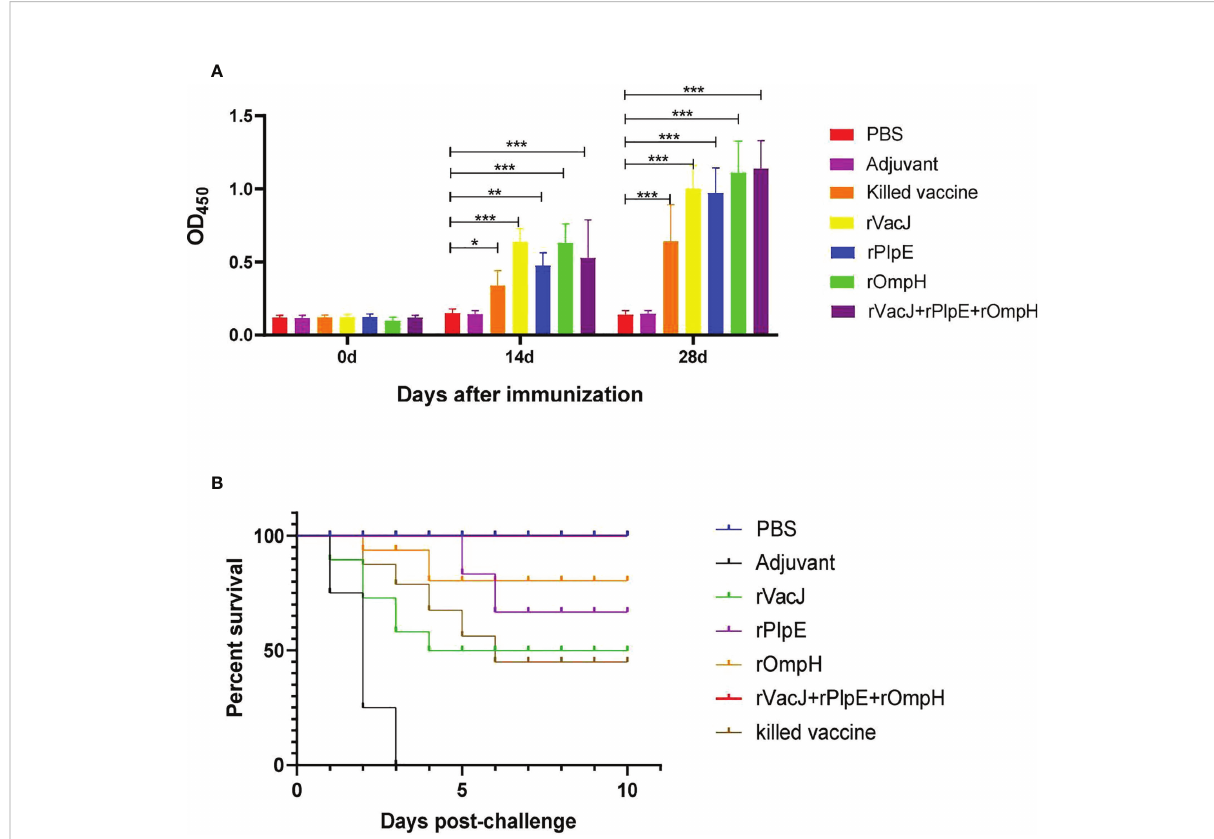
FIGURE 2 In a duck model, the ELISA and protective ef fi cacy of rVacJ, rPlpE, and rOmpH proteins. Panel (A) The bar diagram indicating the rVacJ, PlpE, and OmpH antibody titers (total IgG) of sera collected from all the ducks at 0, 14, and 28 days post-immunization. Panel (B) The survival/ mortality rates of vaccinated and control ducks (12 ducks/group) following challenge with 20 LD50 of P. multocida A:1 strain PMWSG-4. *: P<0.05, **: P<0.01,